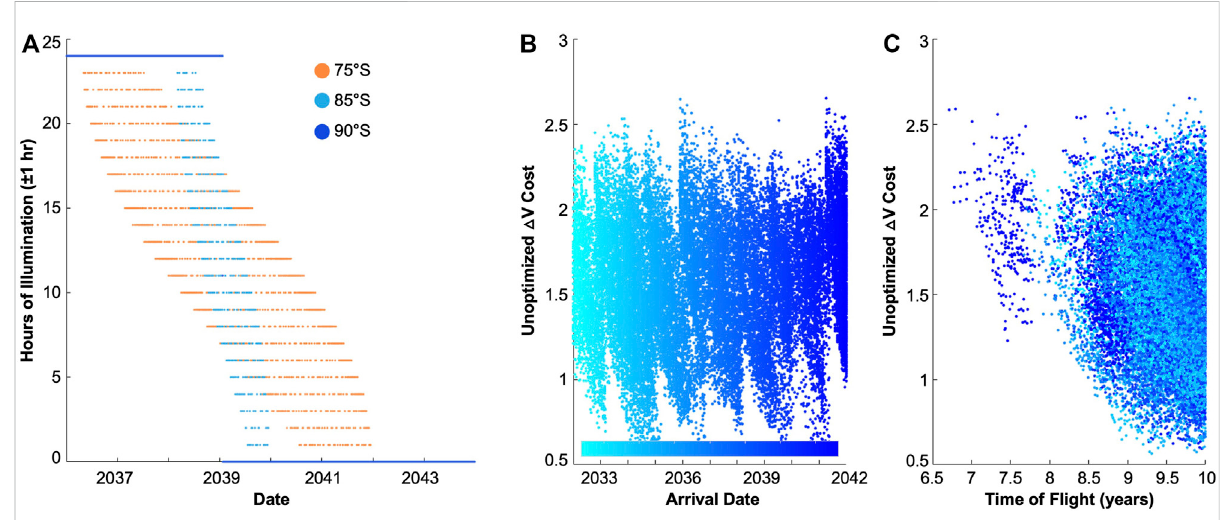
FIGURE 4 (A) Hours of illumination on the surface of Enceladus for each Earth day. Δ V as a function of (B) arrival date and (C) time of fl ight for the interplanetary transfer. The colormap labels the arrival date for the different unoptimized Δ V cost. The same colormap is used to analyze the same results in terms of time of fl ight to evaluate the time of